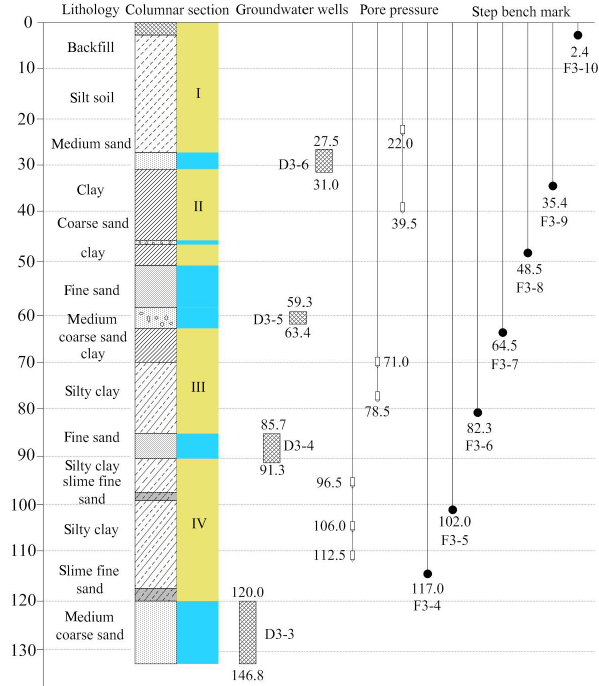
Figure 3. Layout of monitoring facilities above 120m at the Tianzhu Land Subsidence Monitoring Station.